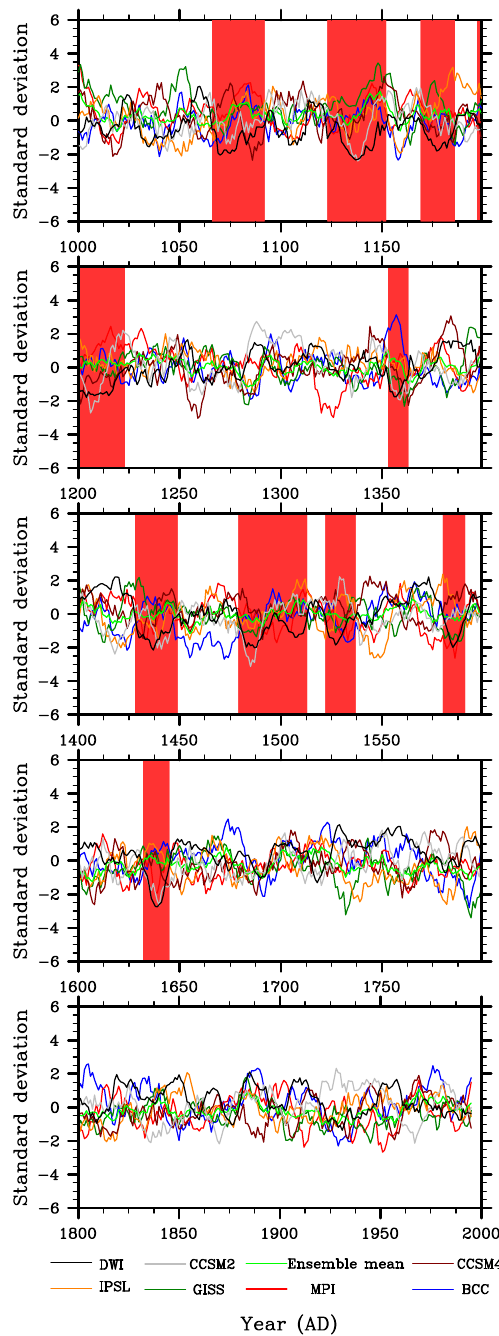
Figure 10. Comparisons between reconstructed and modeled rainy season precipitation anomaly over eastern China during the last millennium. All data are 10-year running averages and standard- ized after smoothing. Ten severe decadal droughts occurred dur-